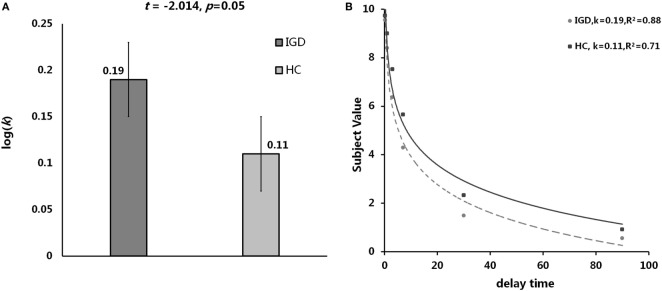
Delay discounting value differences between Internet gaming disorder (IGD) and healthy control (HC). (A) The IGD showed higher k value than HC. (B) Delay discount functions for HC and IGD. Points show mean indifferent points for monetary rewards as a function of delay time. R2 represents how close the fitted curve is from the actual data points. First, the variation between data points and the mean values is calculated. In least-squares fitting, the total sum of squares (TSS) includes two parts: the variation explained by regression and that not explained by regression [the residual sum of square (RSS)]. Then the R2 = 1 − RSS/TSS.